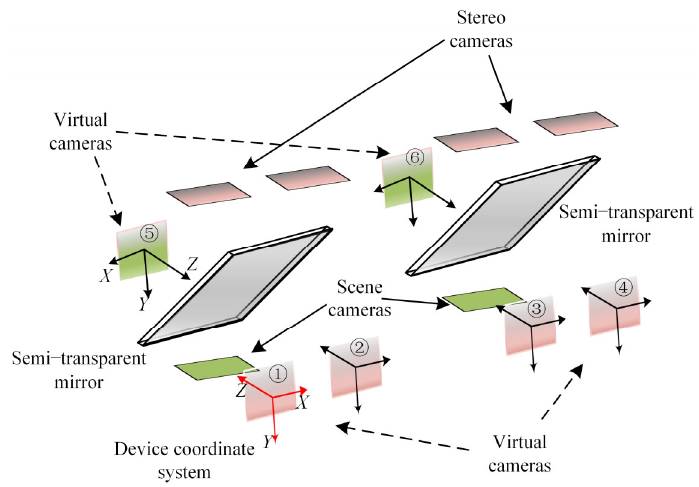
Figure 4. The distribution of the virtual cameras with coordinate system definition in the gaze tracking system.